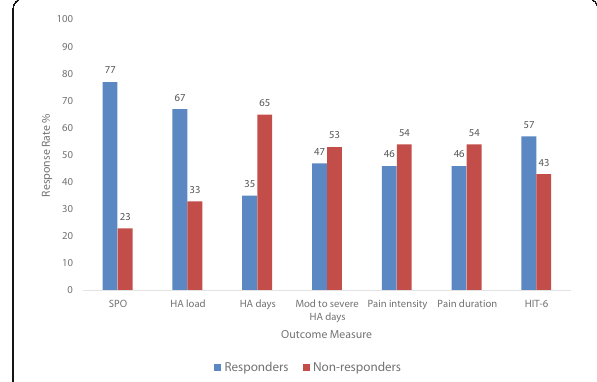
Fig. 1 (abstract O25). Response rate for each outcome measure . Responders ≥ 30% improvement on each outcome measure; ≥ 3 HIT-6 points improvement. HA: headache, SPO: subjective perceived outcome